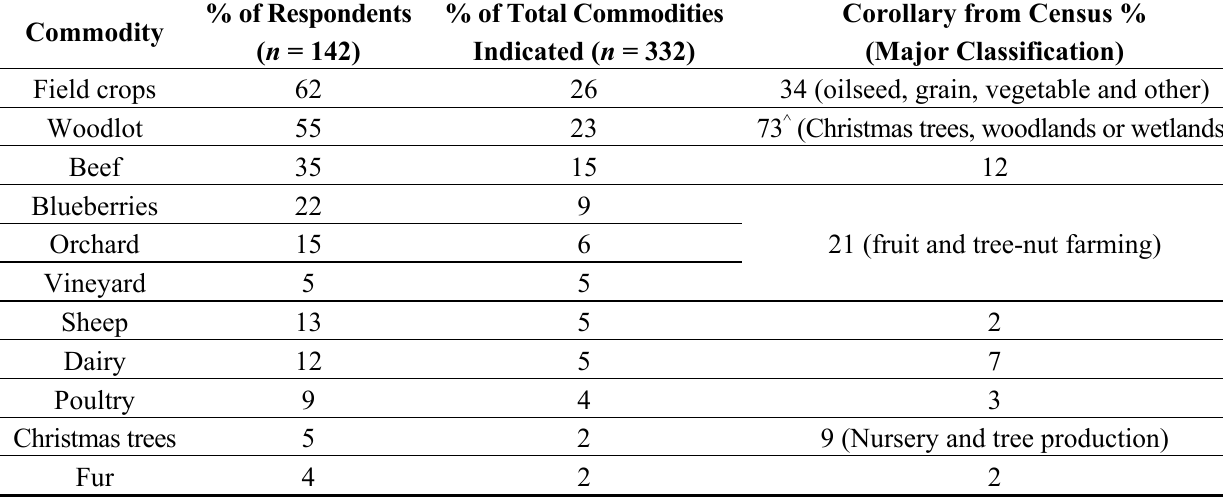
Table 2. Commodity mix of this survey cohort in comparison with the 2011 Census of Agriculture.